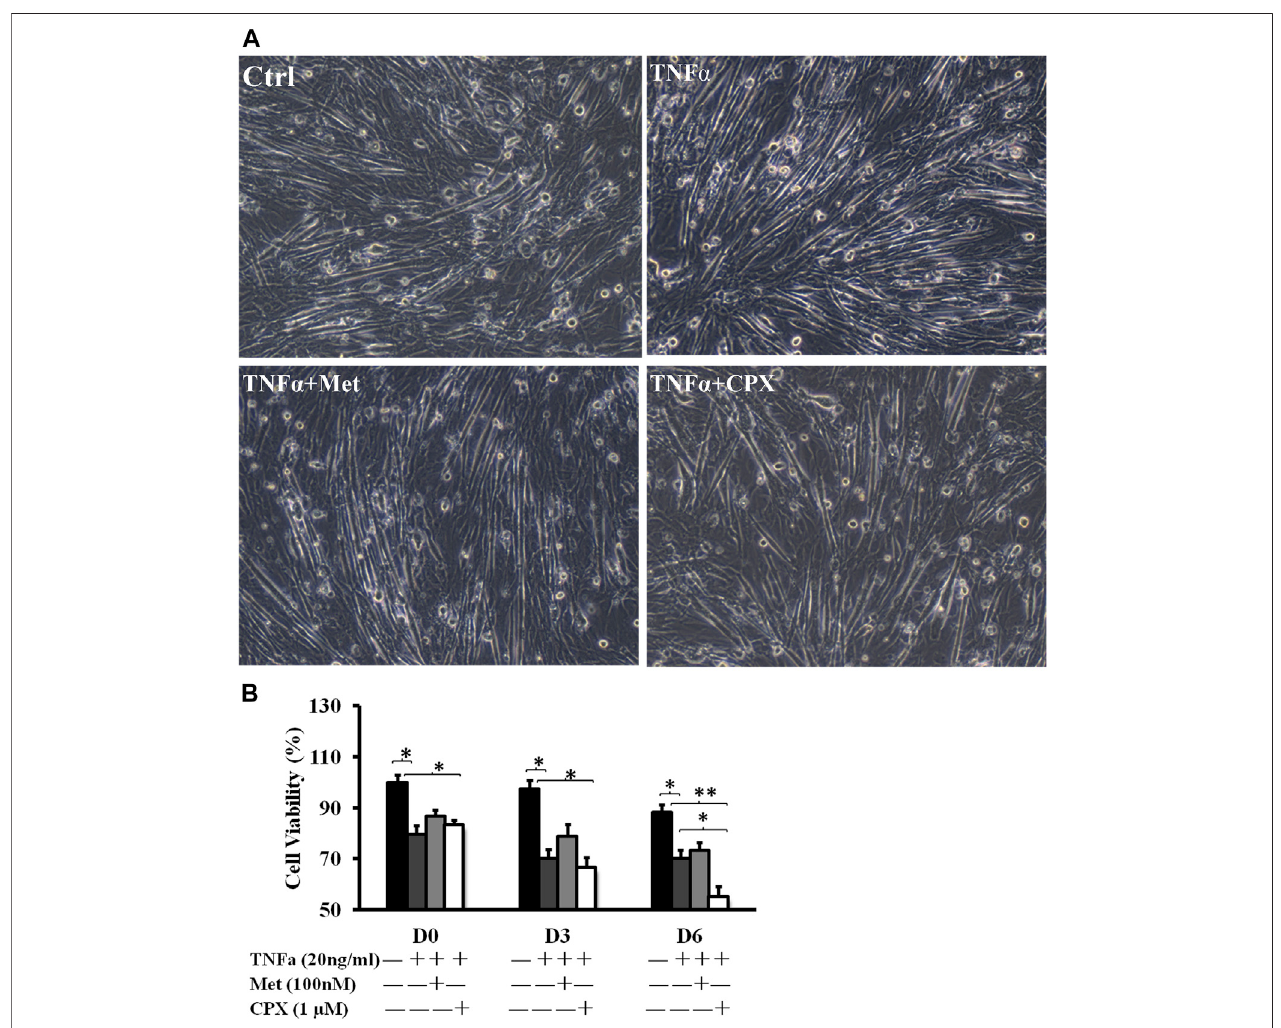
FIGURE 1 | The effect of TNF α , Met and CXP on cell viability. (A) : D6 C2C12 cells incubated in the presence of TNFa (20 ng/ml), TNFa + Met (100 nM) or TNFa + CPX (1 µM) for 12 h and observed by phase contrast microscopy (100 × ). (B) : Viability at D0, D3, and D6. C2C12 cells were incubated for 12 h in the presence of TNFa, TNFa + Met or TNFa + CPX. The cell death was detected by cell count kit-8 assay; * p < 0.05, ** p < 0.01 vs. control of the same differentiation day (black columns); normalizingD0ctrl (cid:2) 100%.TherewasnostatisticaldifferencewhenTNFa+MetorTNFa+CPXwascomparedwithTNFa-treatmentof0-and3-differentiationday (dark gray columns). Ctrl, control; TNFa, murine Tumor Necrosis Factor-alpha; Met, methimepip; CPX, ciproxifan. D0, undifferentiated cells; D3, cells differentiated for 3 days; D6, cells differentiated for 6